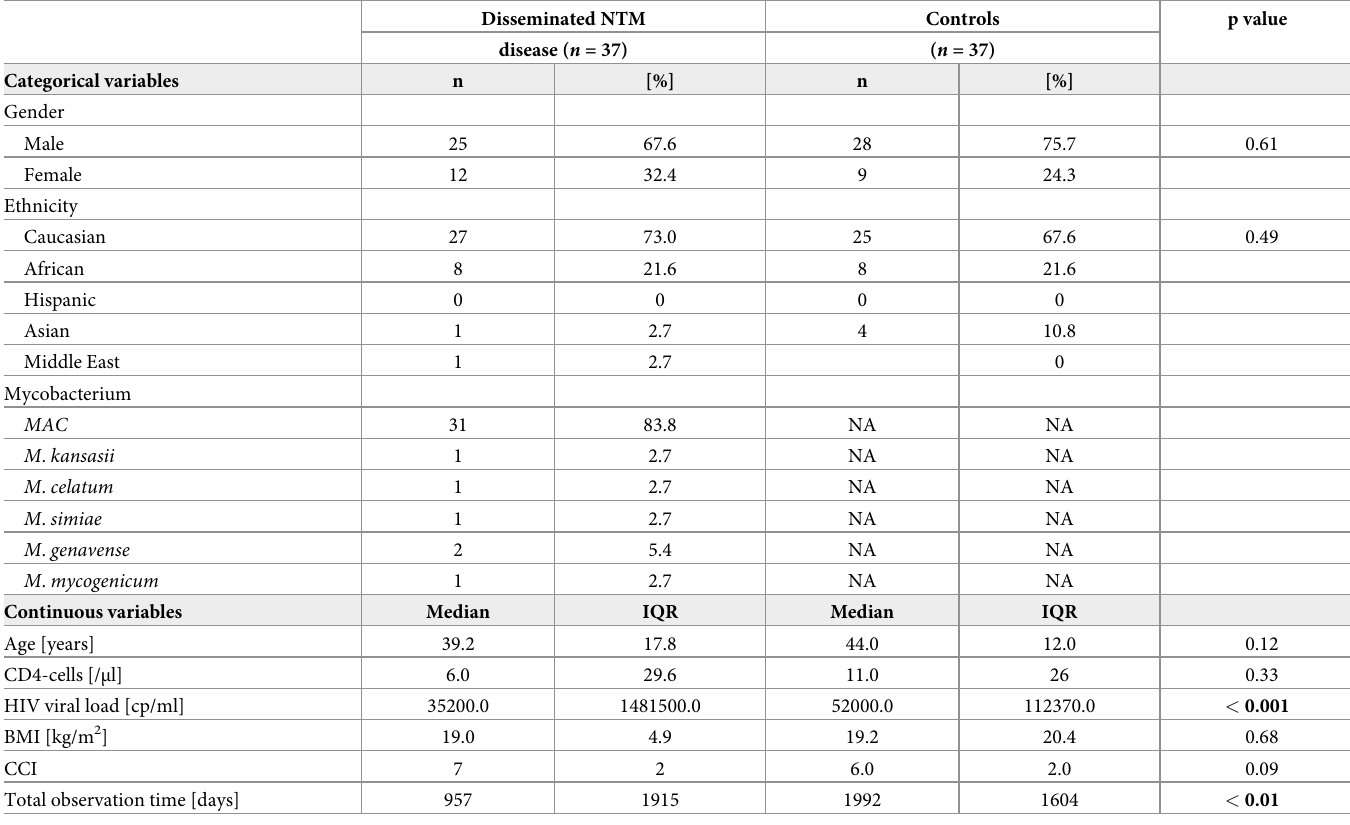
Table 1. General characteristics and mycobacterial species in patients with disseminated NTM disease and controls. CD4-cell counts refer to baseline in patients with disseminated NTM disease and the nadir in